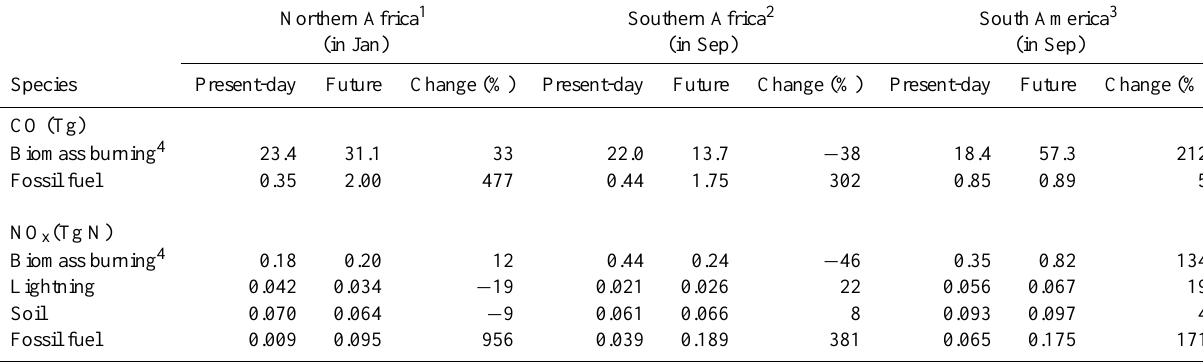
Table 1. Comparison of present-day and future emissions in Africa and South America